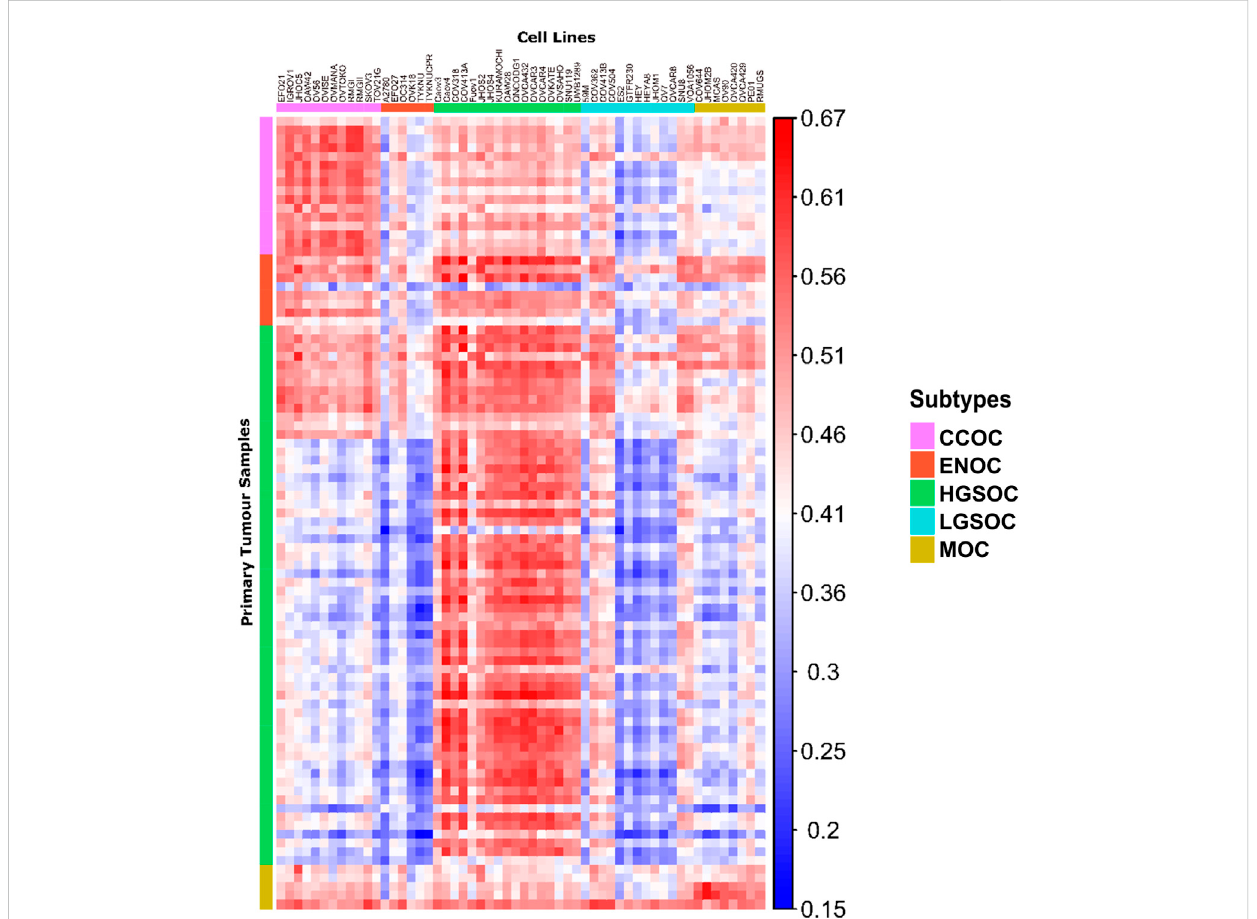
FIGURE 4 Correlation matrix comparing similarity of cell line models to primary tumor tissue of each subtype. Each column represents a cell line, with the putative subtype assigned by NMF delineated by colored boxes (top). Each row represents a tumor sample, with the subtype of samples as identi fi ed by histological assessment shown by colored boxes (left). Each tile shows the correlation of gene expression between a cell line and tumor sample, ranging from 0.15 to 0.67 (blue to